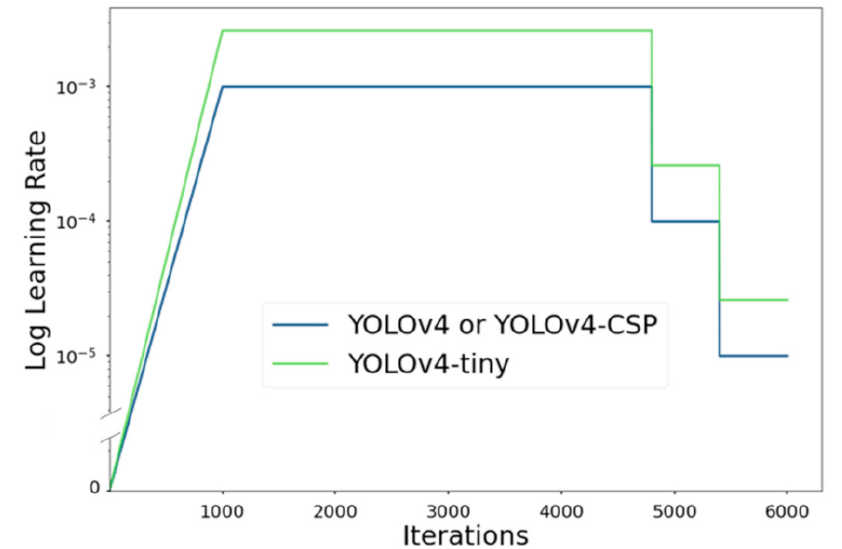
Figure 9. Learning rate schedule of YOLOv4, YOLOv4-CSP, and YOLOv4-tiny, where maximum iteration = 6000. For the first 1000 iterations, a linear warm up policy was done, which is a slow rise of the learning rate. After the 1000th iteration, a multistep decay policy was done. Regarding the optimizer, Nesterov Accelerated Gradient, momentum and weight decay were implemented. The momentum and weight decay were set as 0.949 and 0.0005, respectively, for all the YOLOv4 models. The localization loss was based on Complete IoU (CIoU) [44], which is illustrated in Figure 10. A complete list of the hyperparameters is shown in Table